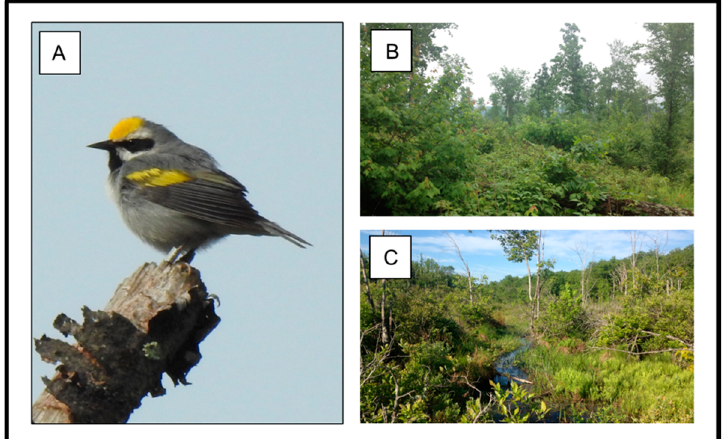
Figure 4. Golden-winged warblers ( A ) are dependent on early-successional communities with a mix of trees, shrubs, saplings, and herbaceous plants such as those provided by regeneration after timber harvests ( B ), and shrublands ( C ) that provide nesting and foraging resources. (Photos by D.J. McNeil.)